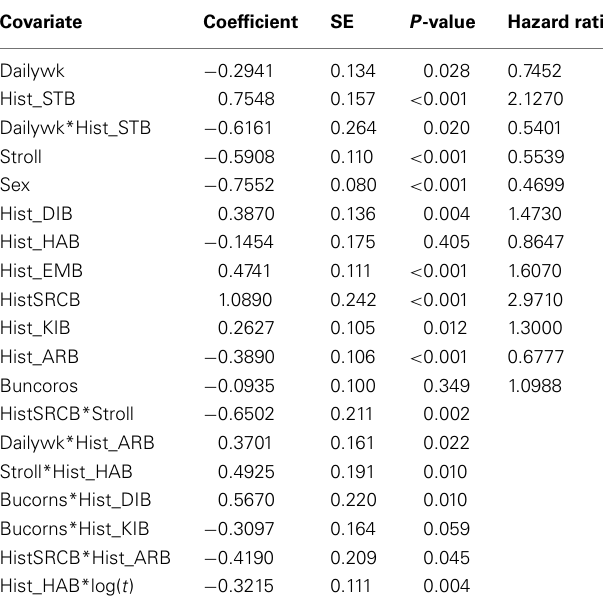
Table 4 | Hazard ratio of mortality for daily walking by the history of some diseases. History